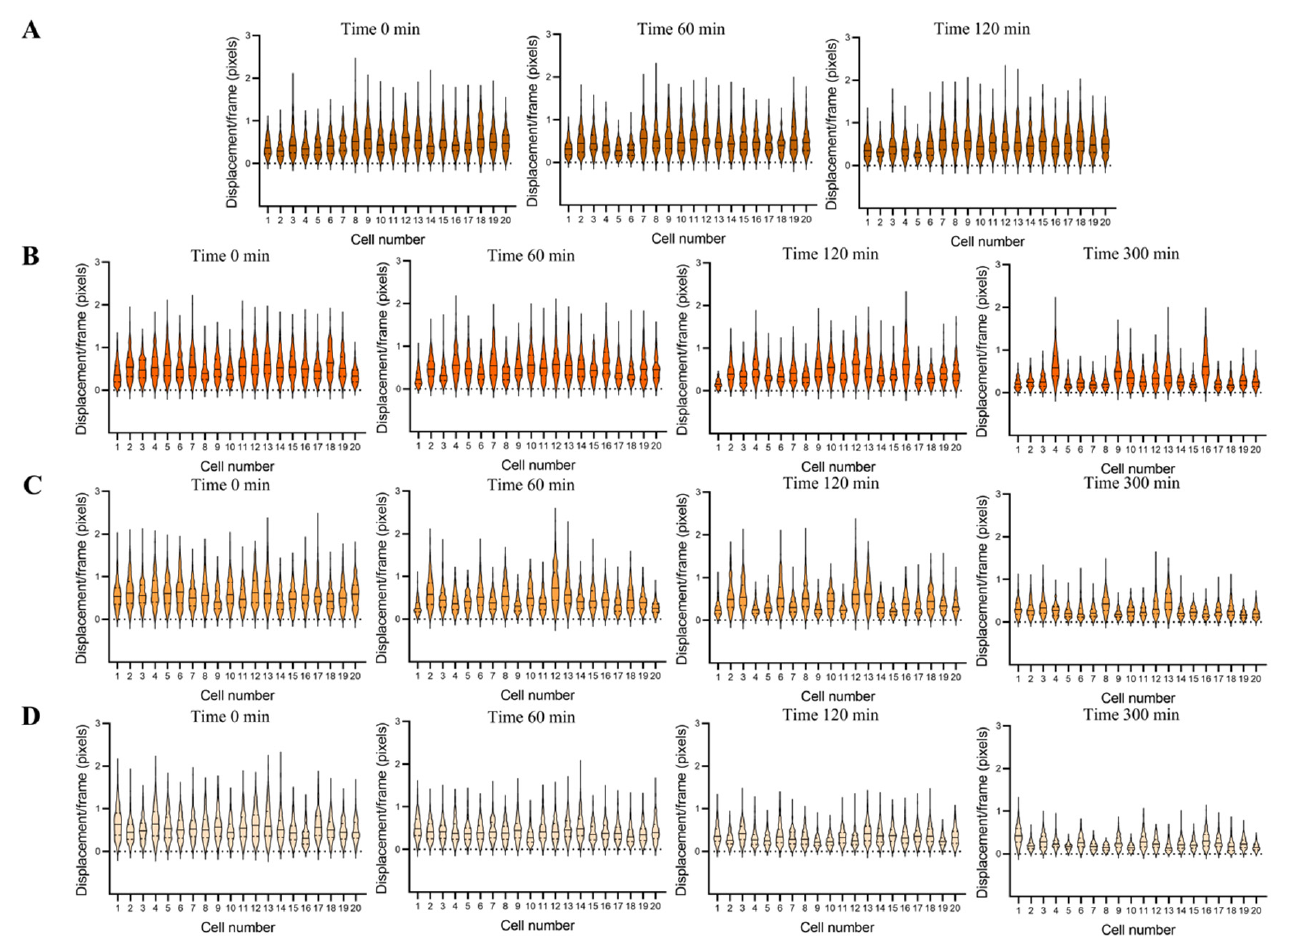
Figure 12. The displacement distribution for 20 single cells of C. albicans CAF2-1 wild-type strain displayed in violin plots during ( A ) 2 h of growth in a YPD medium (control) and during 5 h of treatment with the antifungal fluconazole at ( B ) 0.5 µg/mL, ( C ) 1 µg/mL, and ( D ) 100 µg/mL.